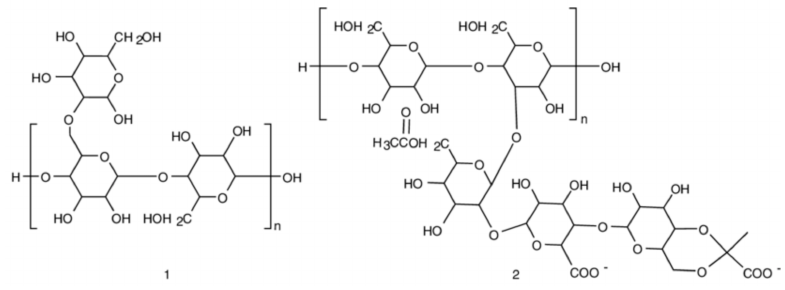
Figure 2. Struturee of guar gum (1) and xanthan gum (2) (retired from